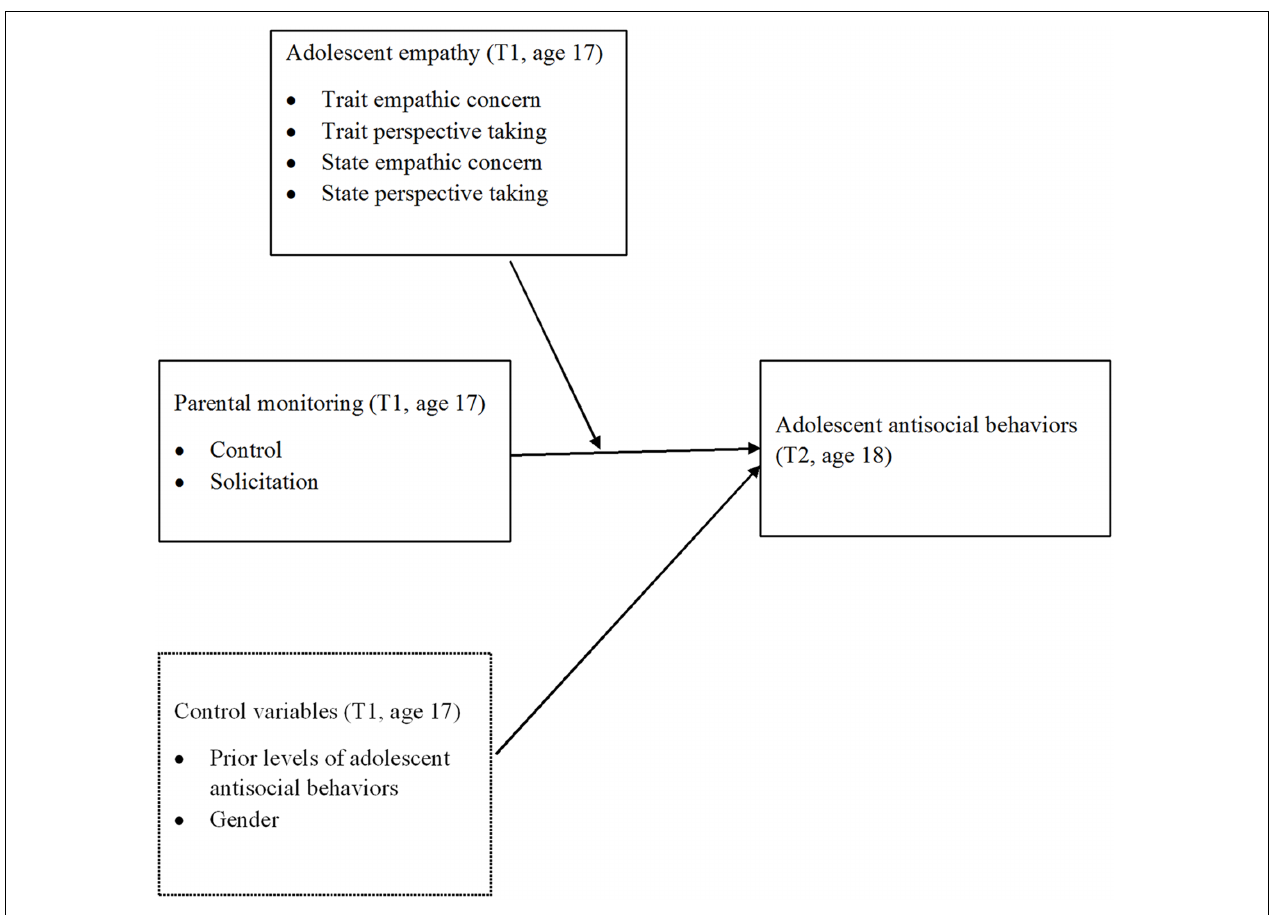
FIGURE 1 | The conceptual moderated